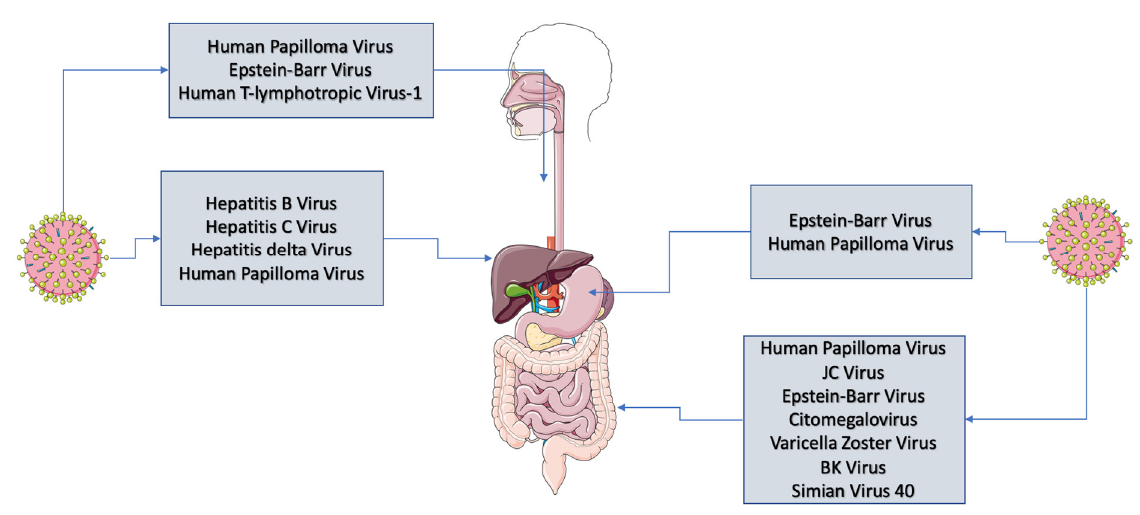
Figure 1. Viruses that might induce carcinogenesis within the gastrointestinal